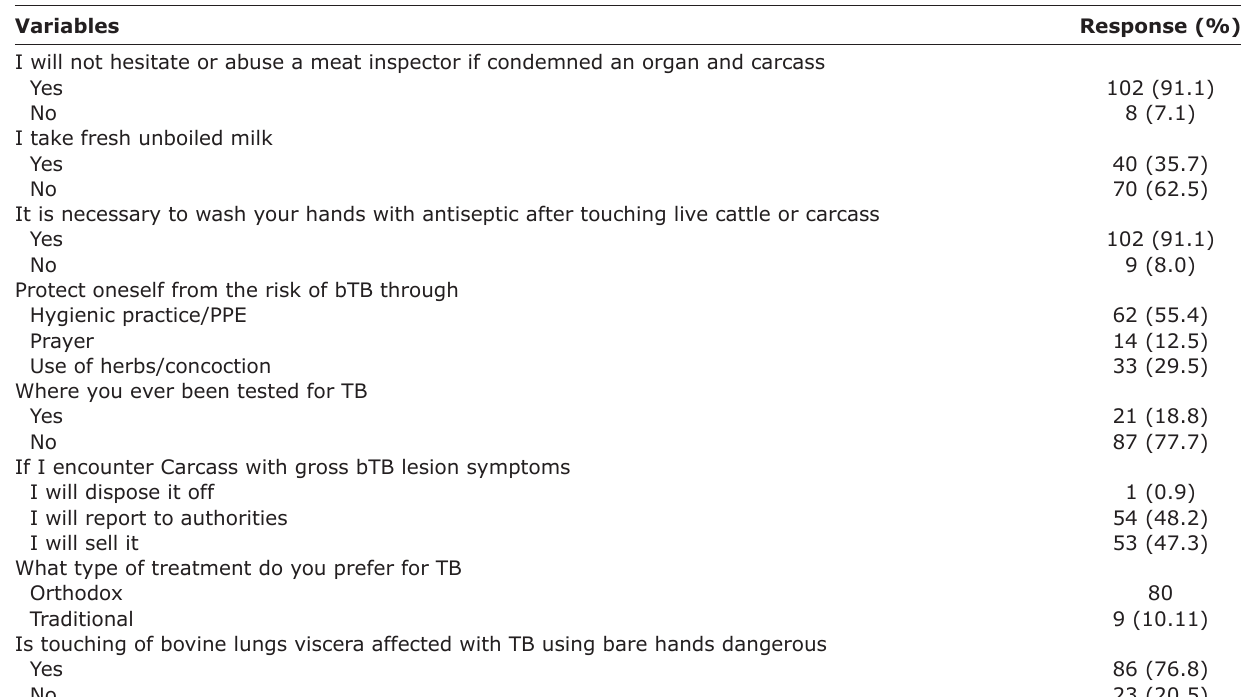
Table-5: Assessment of respondents’ practices toward bTB in Gombe, Gombe State, Nigeria.